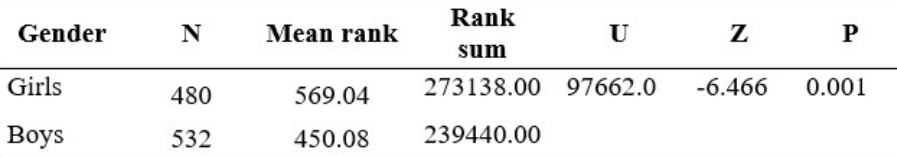
Mann-Whitney U-test result with regard to mathematics study strategy beliefs of secondary school students according to gender